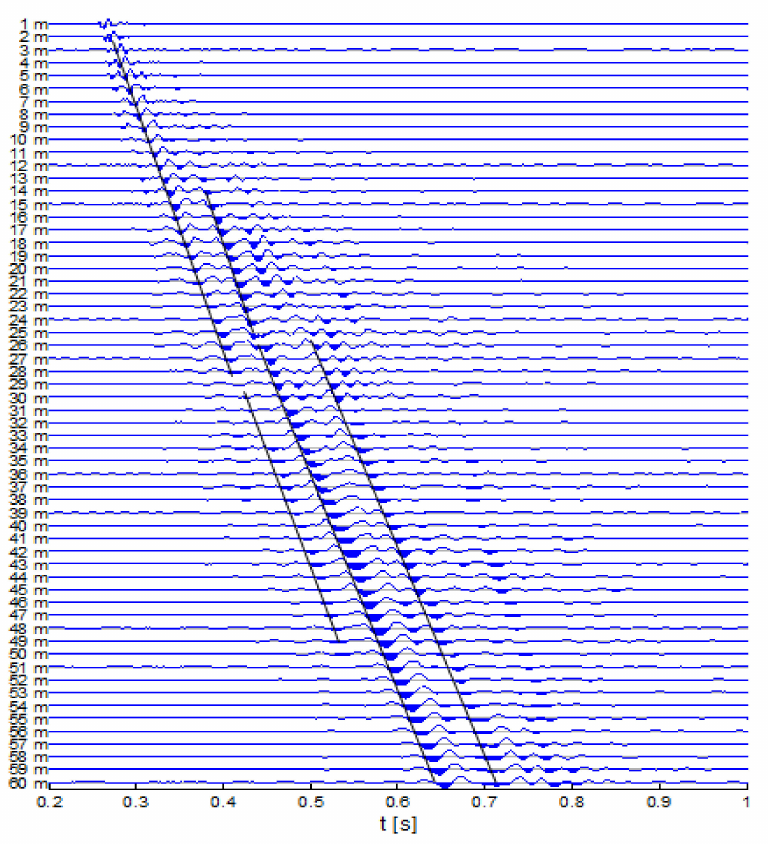
Figure 5. Wave velocity measurements of the soil at Site W; response to hammer impact at 1 to 60 m, v S = 175